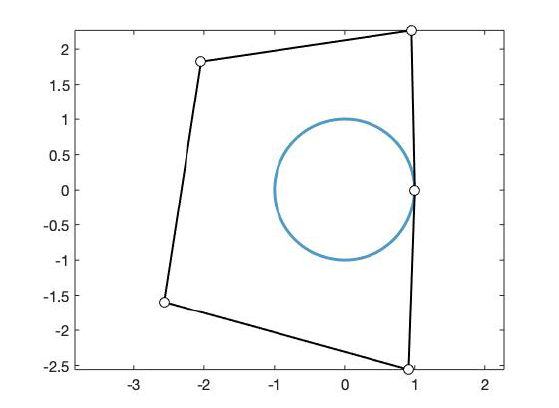
Figure 5. Fitting curve of degree 5 obtained using the functions f ( t ) = t and g ( t ) = 1 − t , t ∈ [ 0,1 ] , and its corresponding control